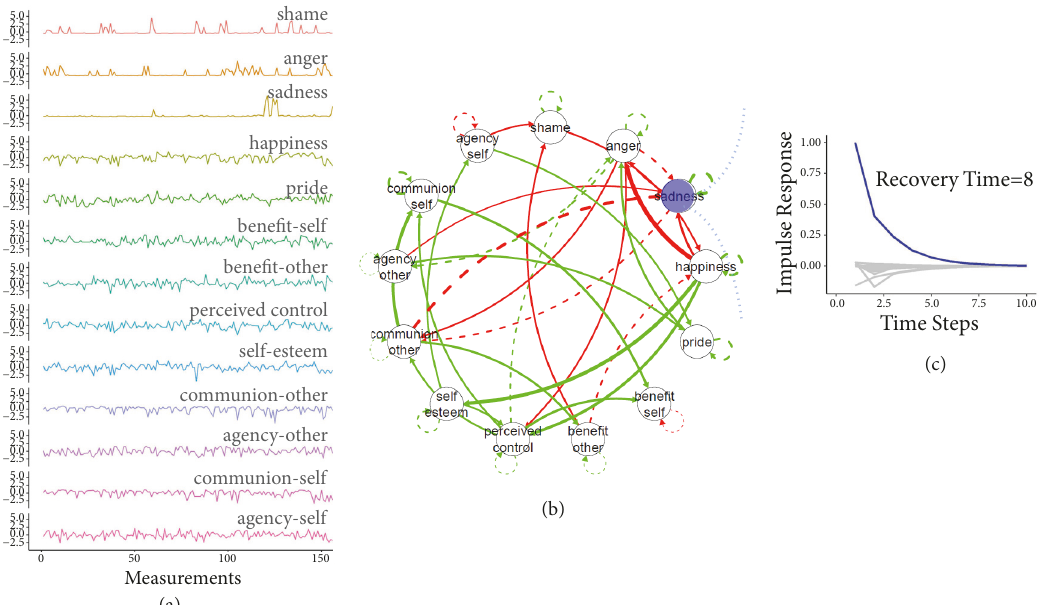
Figure 2: Illustration of the time-series, network graph, and impulse response analysis for one individual. (a) is the standardized time-series of 13 variables of one burst from one individual. (b) is the network graph of the temporal relations in the time-series from (a), obtained using uSEM. (c) is the time profile of the impulse response analysis of the network in (b) (sadness is represented by the blue line; the other twelve variables are represented by grey